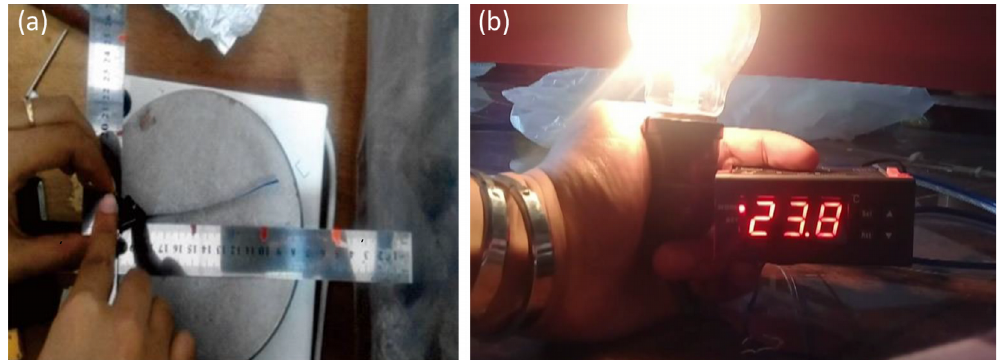
Figure 11. Experiment designs of (a) bimetal strip model and (b) thermostat-equipped egg